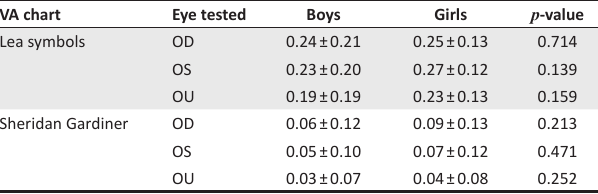
VA, Visual acuity; OD, right eye; OS, left eye; OU, both eyes. a,b , the mean visual acuity scores with different superscript is statistically significant at 95 % confidence interval. TABLE 2: Comparing the performance of boys and girls with both charts. VA chart Eye tested Boys